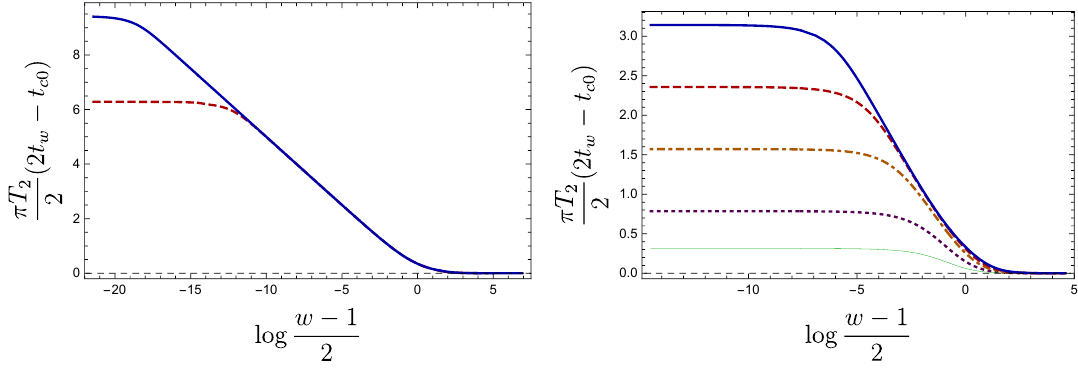
Figure 5. Dependence of the critical time t c 0 on the energy of the shock wave, parametrized by the temperature ratio w for BTZ. In the left, we show the behaviour of t c 0 with respect to early shock waves with T 2 t w = 3 in solid blue, T 2 t w = 2 in dashed red. Similarly to t c 1 in (cid:12)gure 4, as w approaches one, there is a stretched range of w such that t c 1 grows as a logarithm, and the earlier the shock wave the longer this log regime. Also, we see that it approaches 2 t w in the large w regime. In the right, we show the behaviour of t c 0 when the shock wave is not sent early enough, with T 2 t w = 0 : 1 ; 0 : 25 ; 0 : 5 ; 0 : 75 ; 1 from bottom to top. As the shock wave is sent earlier, the region with log dependence becomes more